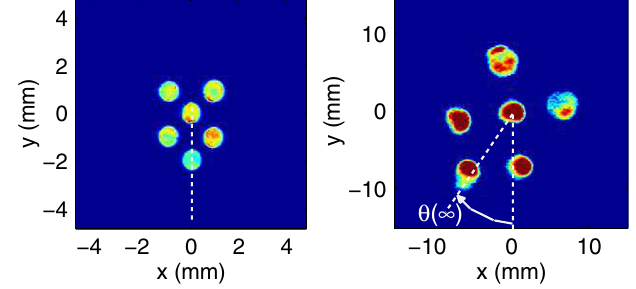
FIG. 4. (Color) False color image of the measured uv laser transverse distribution on the virtual cathode (VC) location (left) and corresponding measured electron beam distribution at YAG1 location (right). The total charge is Q ¼ 20 (cid:9) 2 pC .